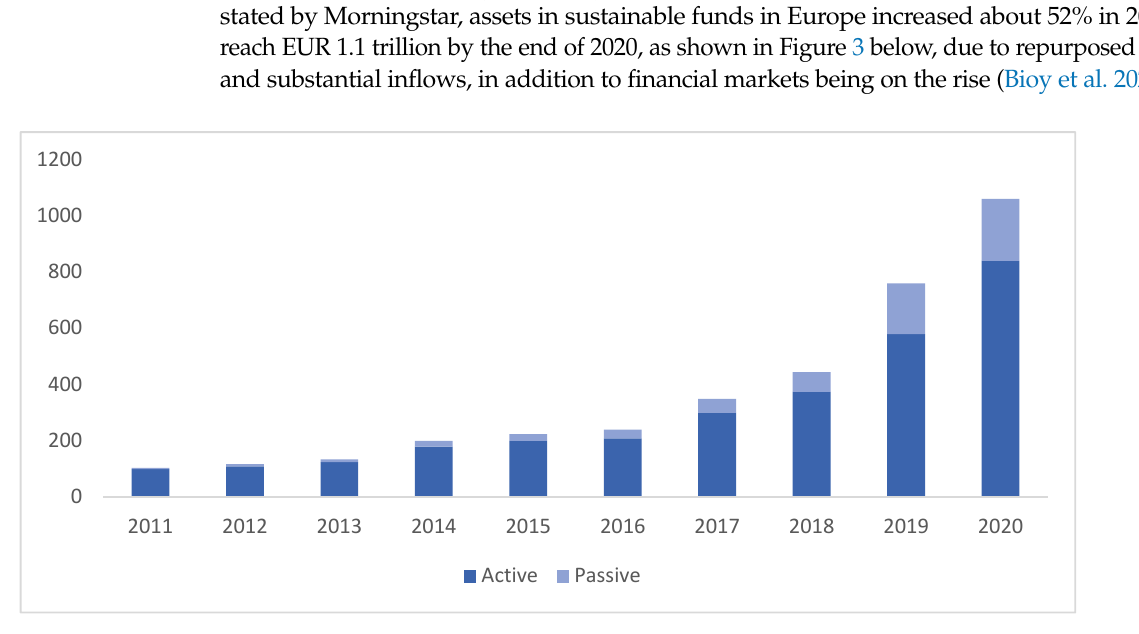
Figure 3. Annual European Sustainable Fund Assets (EUR billion) . (Bioy et al. 2020).